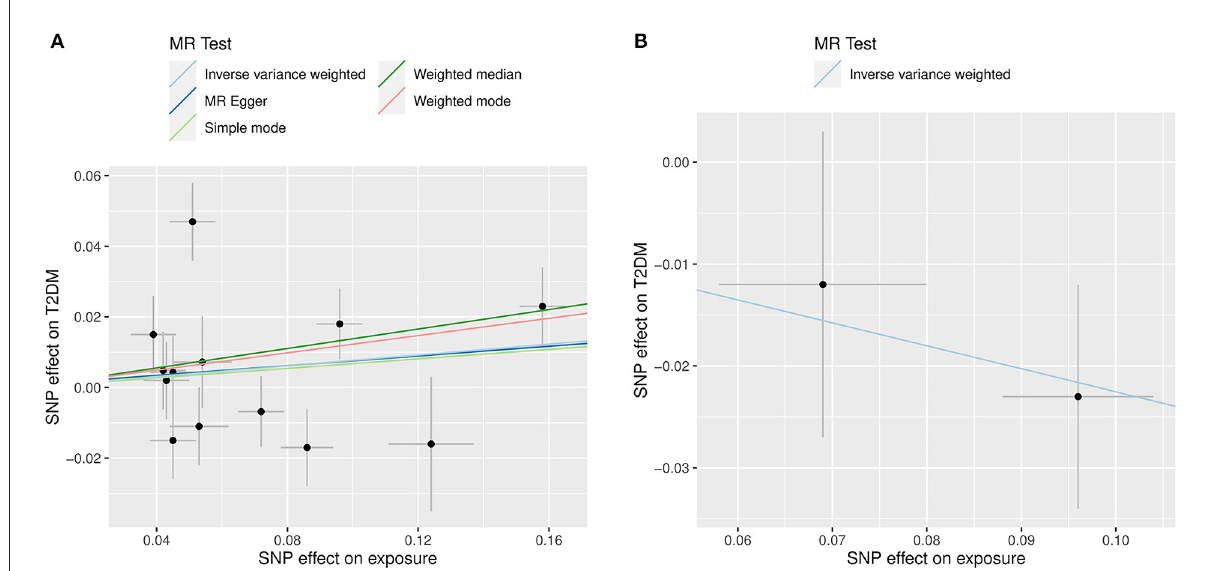
FIGURE4 Scatter plots illustrating the results of the summary-level Mendelian randomization analysis. The x-axis presents the effect of exposure variables and the y-axis denotes the effect of outcome. The analysis was performed on 898,130 individuals of European ancestry from the DIAMANTE consortium. (A) Represents the effect of SNP on homocysteine levels (X-axis, per SD) and on T2DM [Y-axis, log (OR)], 95% CI; (B) Indicates the effect of SNP on folate levels (X-axis, per SD) and on T2DM [Y-axis, log (OR)], 95%